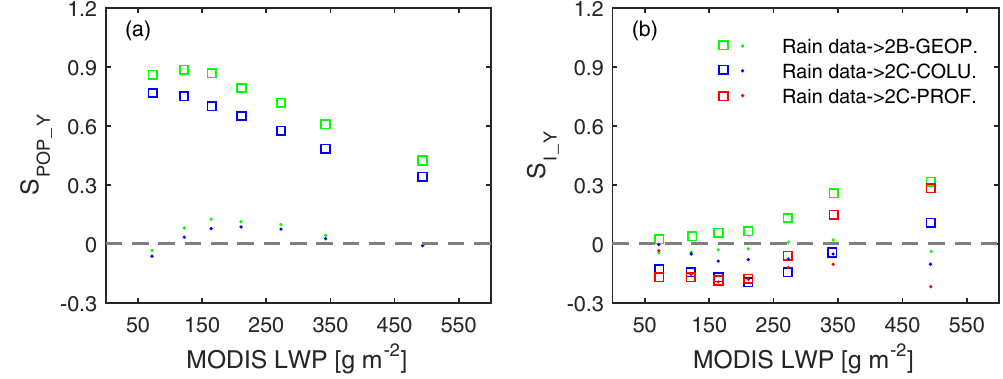
Figure 10. (a) S POP_Y and (b) S I_Y as a function of MODIS LWP. The subscript Y denotes different aerosol proxies corresponding to AI (point) and CDNC (square). Different color symbols stand for different rain products: 2B-GEOPROF (2B-GEOP, green), 2C-PRECIP- COLUMN (2C-COLU, blue), and 2C-RAIN-PROFILE (2C-PROF, red). See text for further details.